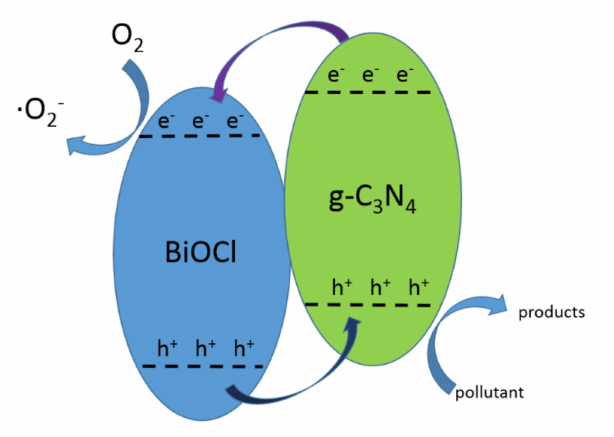
Figure 5. The mechanism for the generation of reactive radicals over